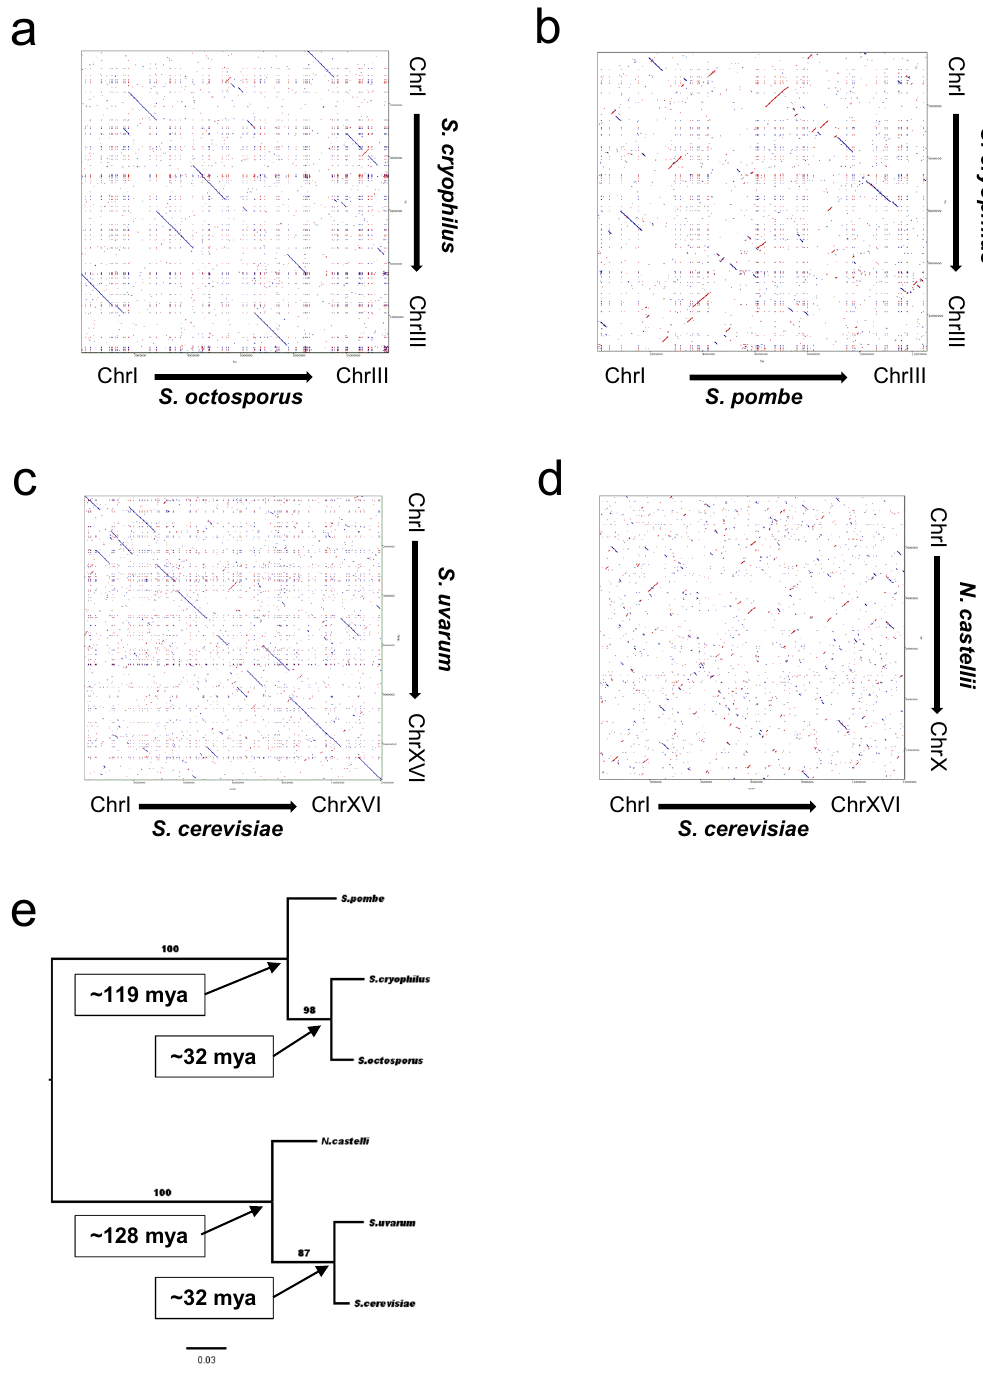
Figure 3. Dot-plot alignments created with YASS 50 (E < 1.0E-30) using the concatenated whole genome sequences of the species. The alignments clearly show that interchromosomal translocations were more frequent than inversions in short evolutionary terms. Blue lines represent homologous segments in the same orientation, while red lines represent inverted segments. ( a ) S. octosporus and S. cryophilus alignment; ( b ) S. pombe and S. cryophilus alignment; ( c ) S. cerevisiae and S. uvarum alignment; ( d ) S. cerevisiae and N. castelli alignment. First species located to the horizontal axis and the latter located to the vertical axis. High resolution pictures of these alignments are available in Supplementary Fig. 4(a–d). ( e ) Phylogenetic relations of the concerning species. Values at the branches are statistical supports come from 100 bootstrap replicates. Numbers in the boxes indicate the dates of divergences 8 . Mya: million years